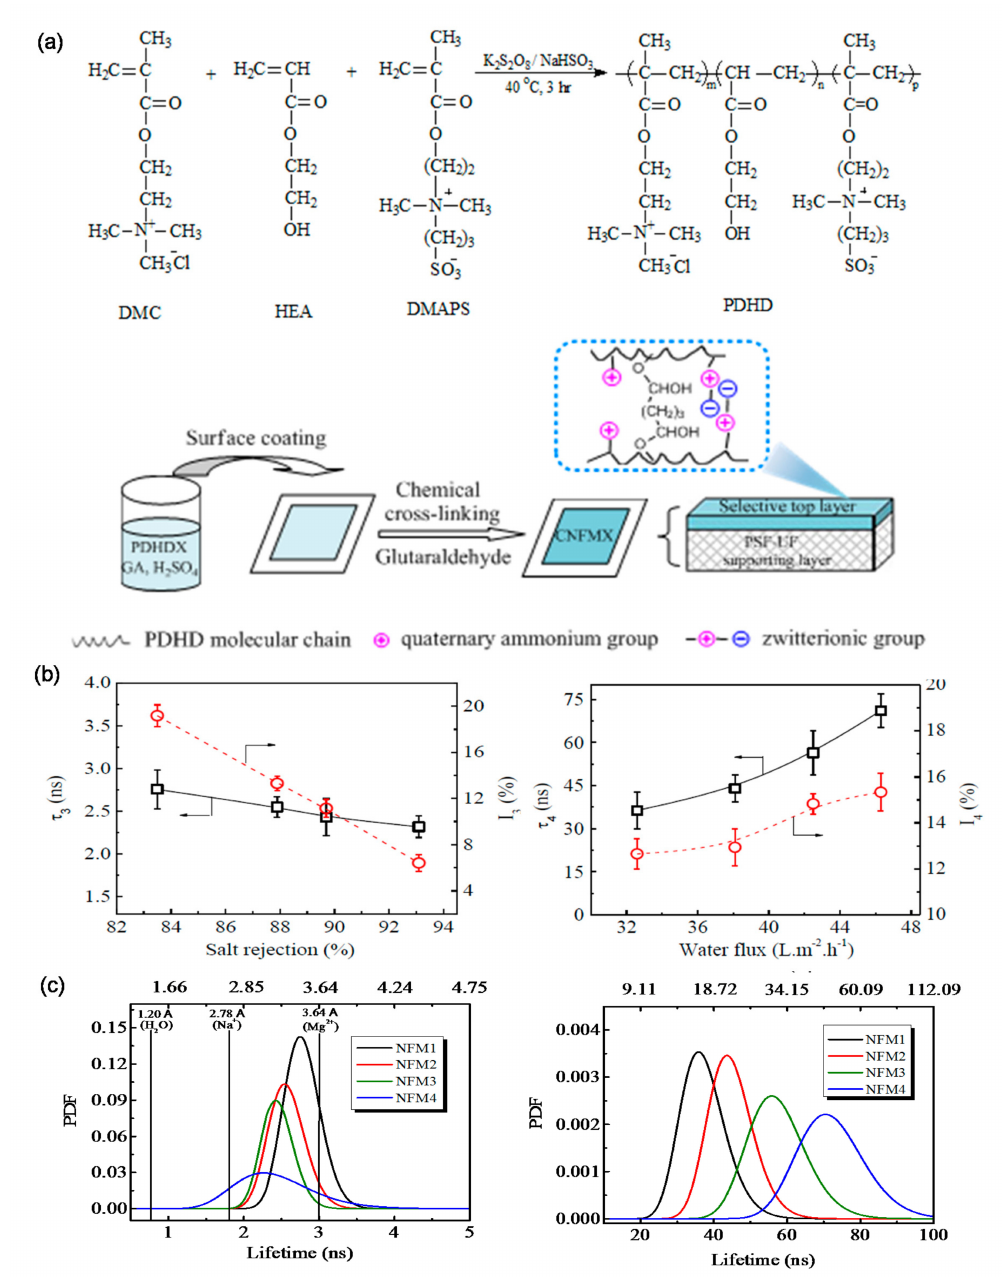
Figure 19. ( a ) Schematic diagram for preparing zwitterionic terpolymers PDHD and their composite nanofiltration membranes fabricated with surface coating and chemical cross-linking method; ( b ) Nanofiltration performance (MgCl 2 /NaCl selectivity/water flux) versus o-Ps lifetime and intensity of NFMs; ( c ) o-Ps lifetime distributions data for zwitterionic composite nanofiltration membranes (PDF = Probability Density Function). Reproduced with permission from References